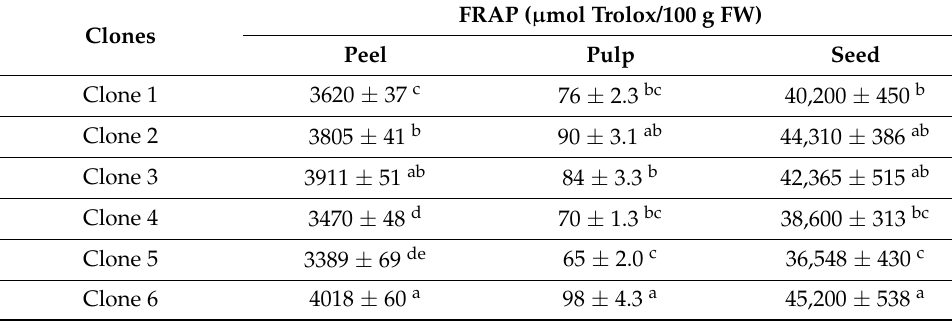
Table 4. FRAP assay results of ‘Köhnü’ grape